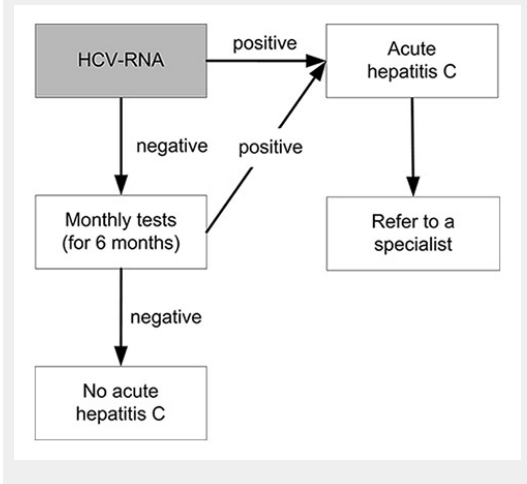
Testing for acute hepatitis C virus (HCV) infection after exposure: in the acute phase of infection HCV ribonucleic acid (RNA) becomes detectable before anti-HCV. A suspected acute HCV infection must be investigated by means of a HCV RNA test.